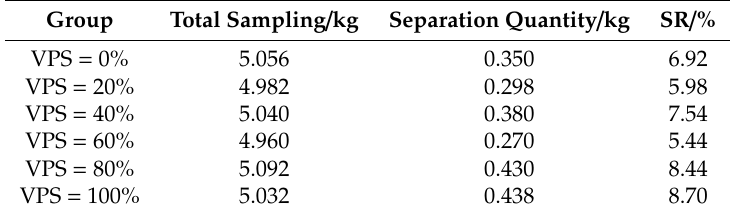
Table 13. Sieve analysis test